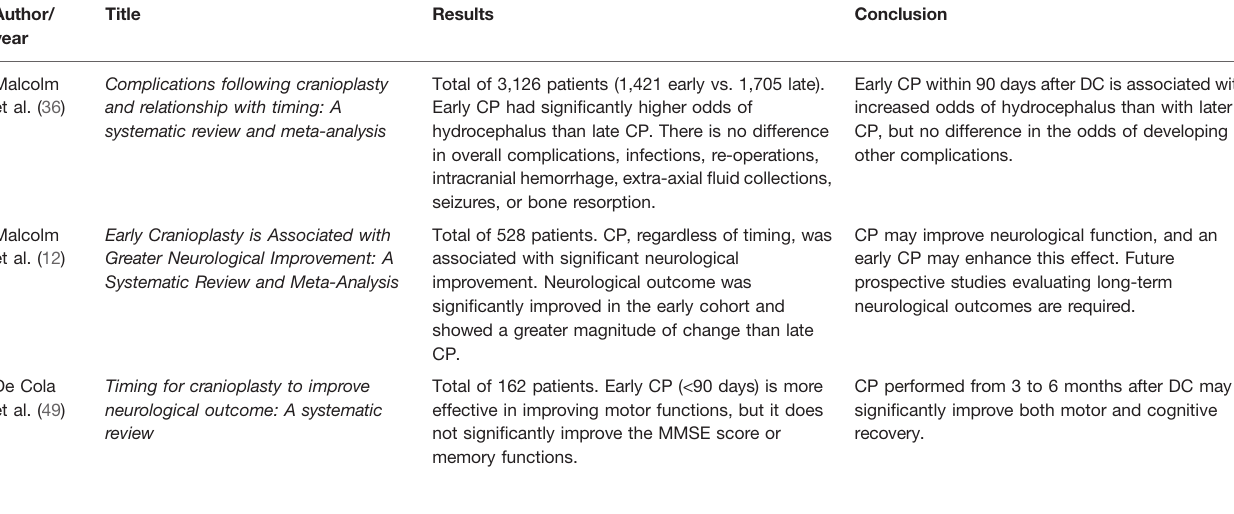
TABLE 2 | In fl uence of timing on complications and neurological outcomes — recent systematic